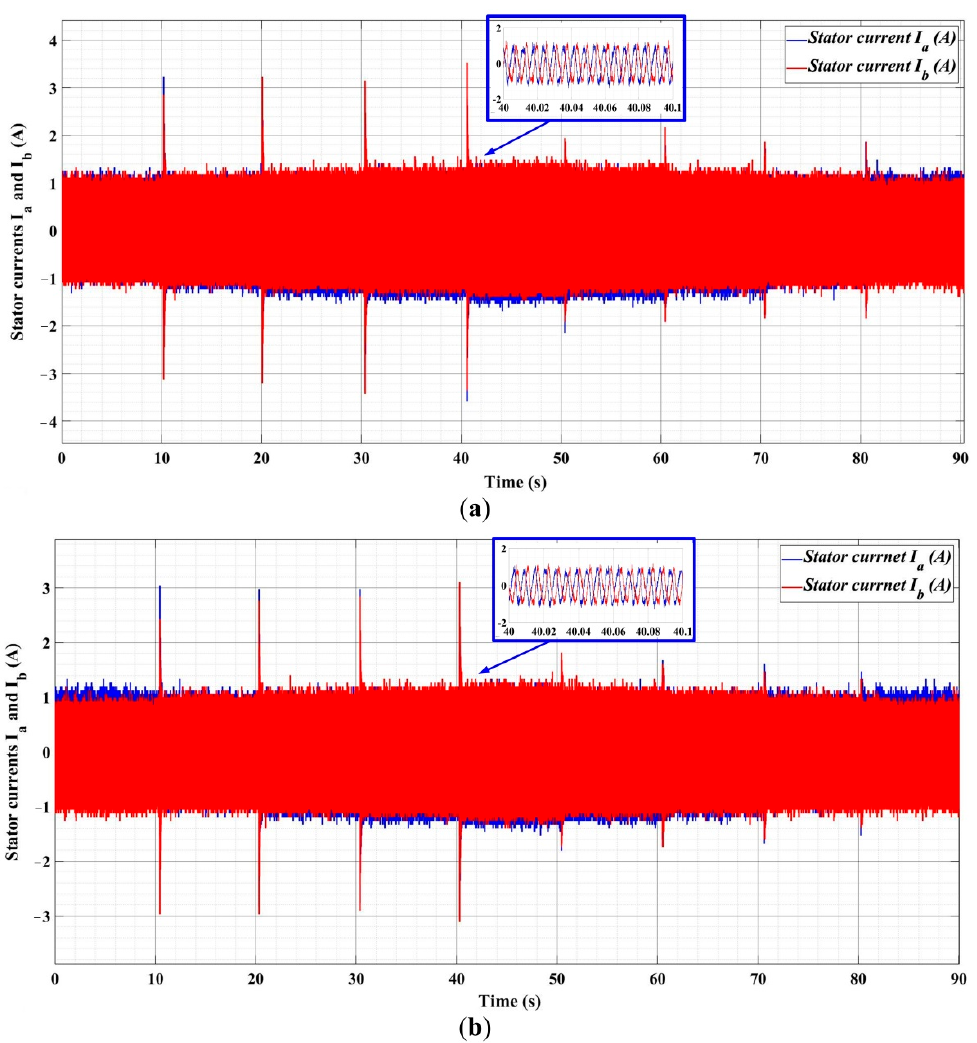
Figure 44. Comparative real-time evolution of the i a and i b stator currents: ( a ) with PI-PSO controller; ( b ) with backstepping controller.